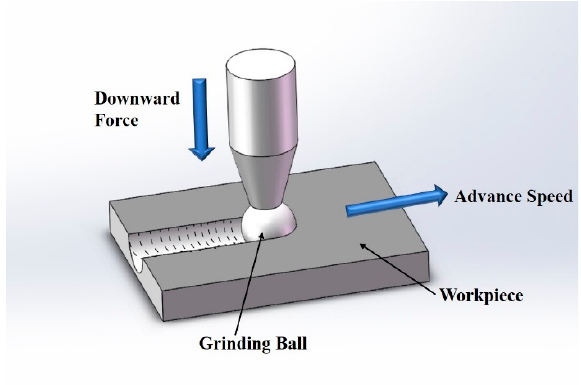
Figure 2. The schematic of the wear test.